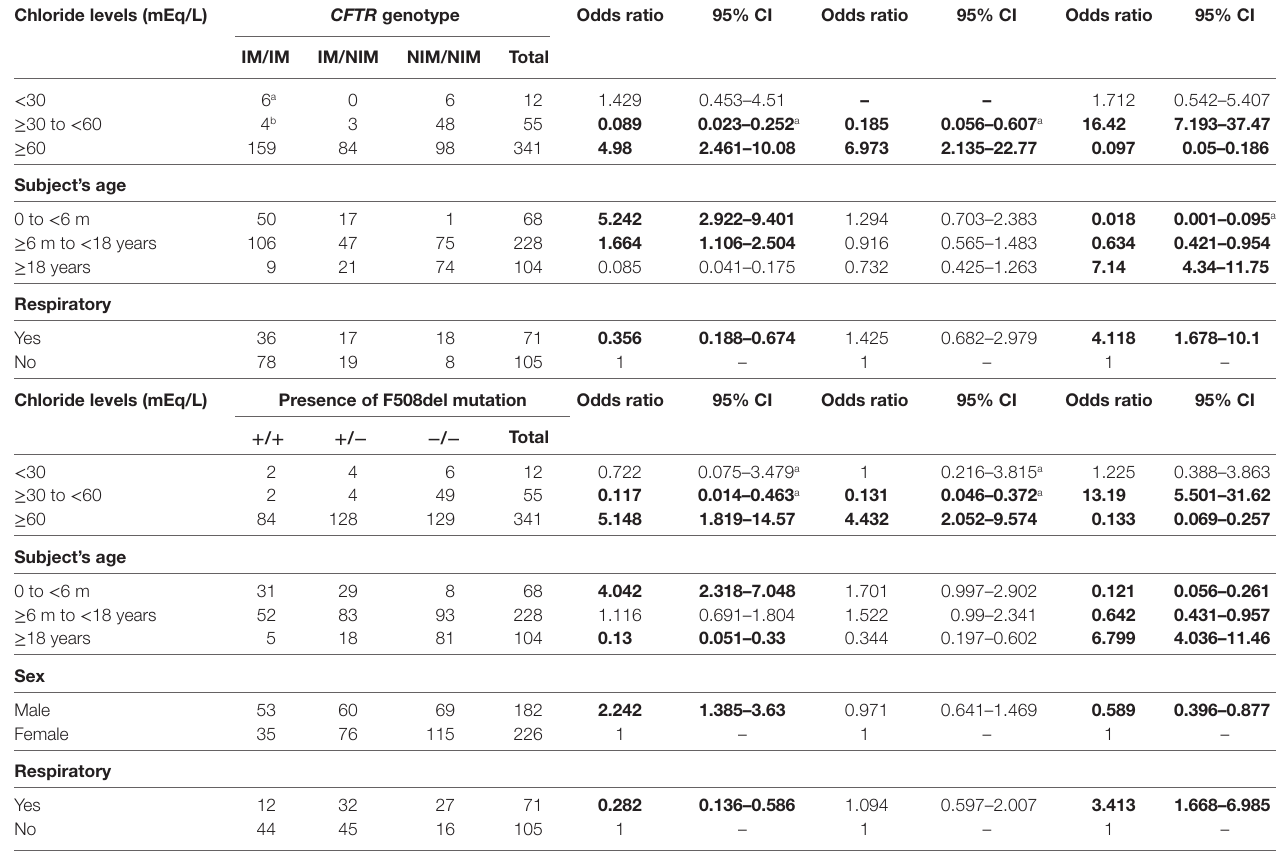
Table 6 | Association between sex of the subject, reason for indication of sweat test, result achieved from sweat test, and subjects’ ages with CFTR mutation screening. chloride levels (meq/l)